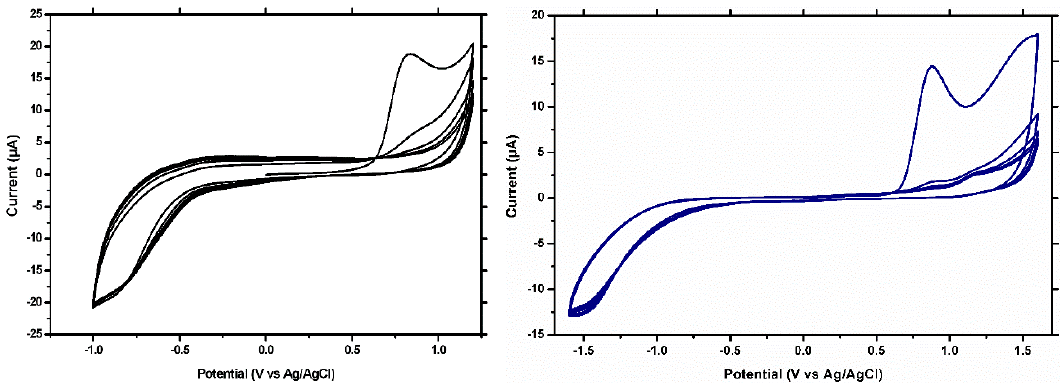
Figure 1. CVs for MIP formation on the GCE ( left ) and on the BDDE ( right ).